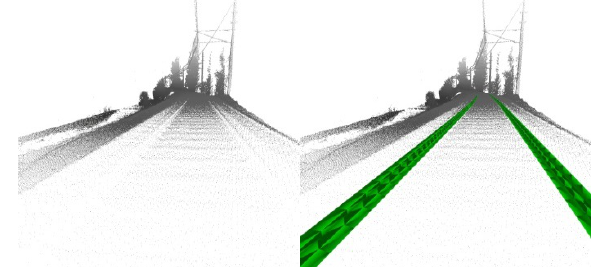
Figure 10. Point cloud (left) overlaid with 3D rail models (right), of part of area 1.